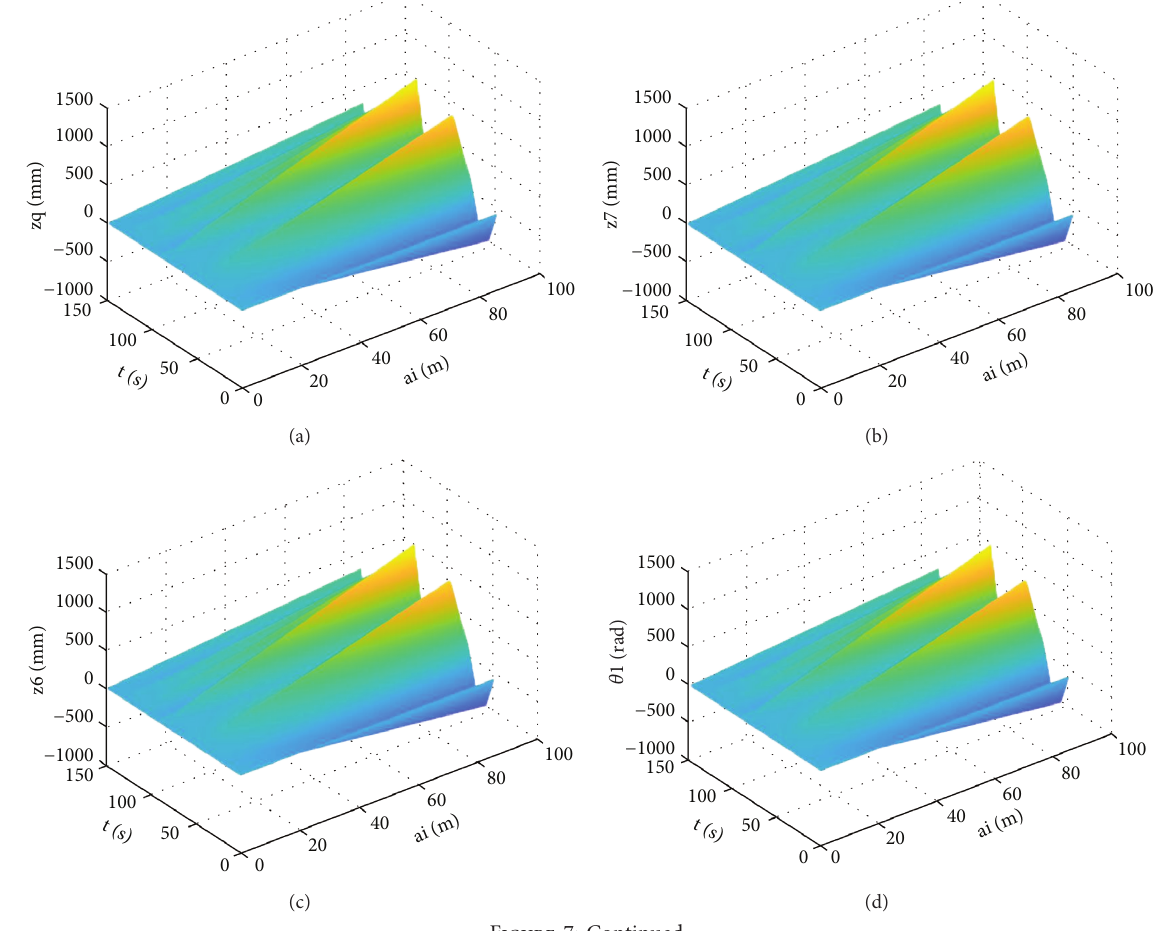
q changing with time. (b) The curve of z 7 changing ′ changing with 2